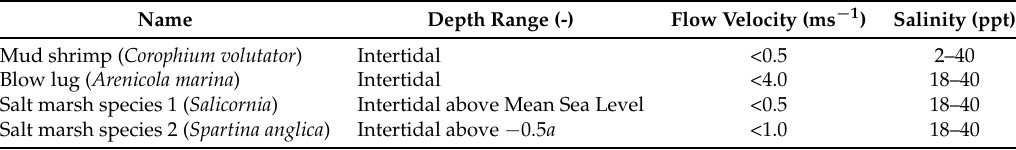
Figure 13. Potential habitat area (in green) as part of total width for the species in Table 1. Table 1. Habitat preferences of species used in this study based on MarLIN